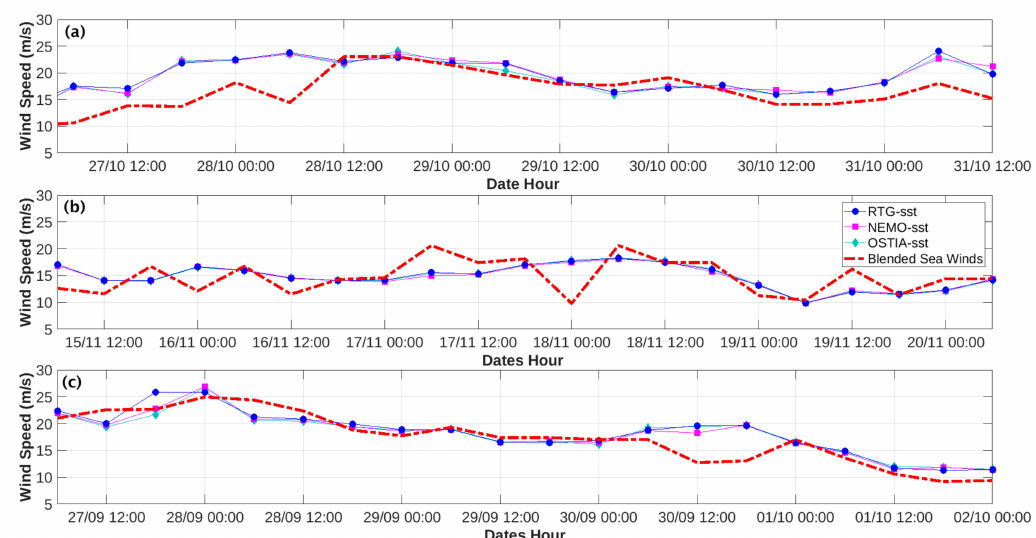
Figure 13. Maximum surface wind speed evolution from RTG-sst, NEMO-sst, and OSTIA-sst simulations and Blended Sea Winds during ( a ) cyclone Trixi, ( b ) cyclone Numa, and ( c ) cyclone Zorbas.